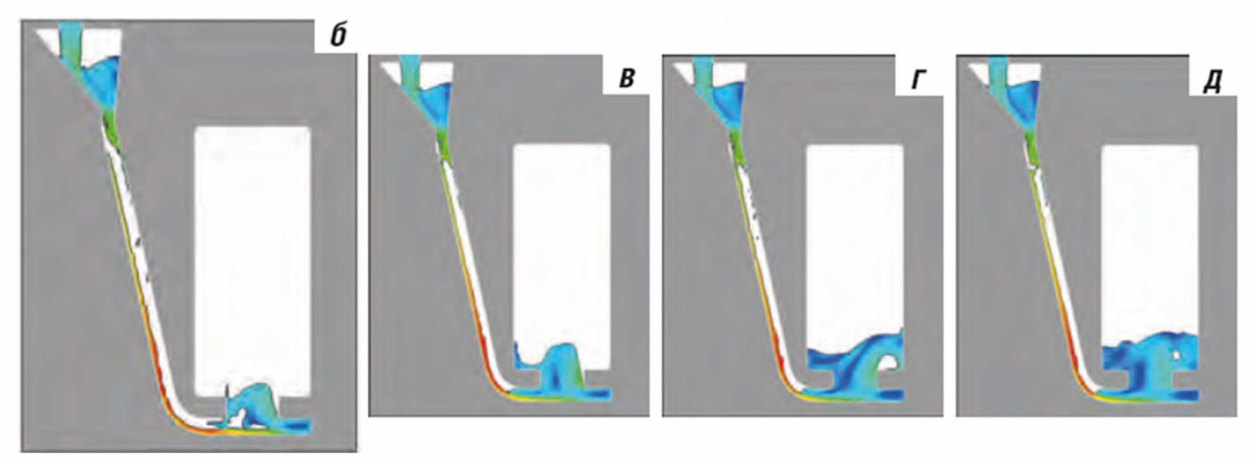
Figure 5. Inclined sprue without tapering [22].